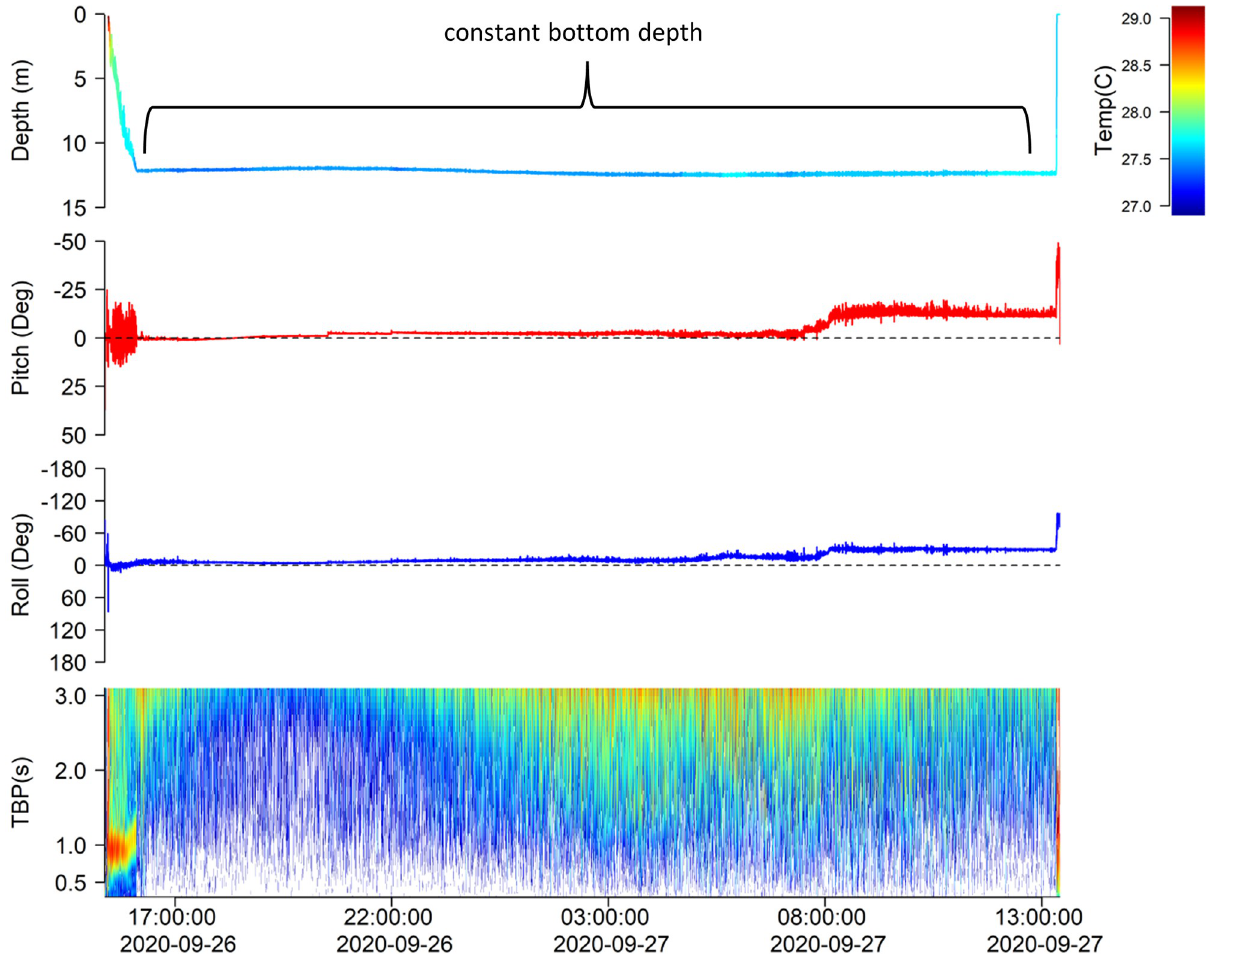
Fig 3. Example of recovered ADL data from a blacktip shark (C_lim07). After tagging, this shark swam away into increasing deeper water, with a tail beat frequency of ~1 Hz. After 40 minutes this shark landed on the seafloor in an upright (normal) posture and stopped displaying regular tailbeats. The shark remained on the seafloor without any tailbeats for a further 21 hours before the release mechanism triggered the tag to detach from the shark. This constant seafloor depth and lack of tailbeats on the seafloor indicates